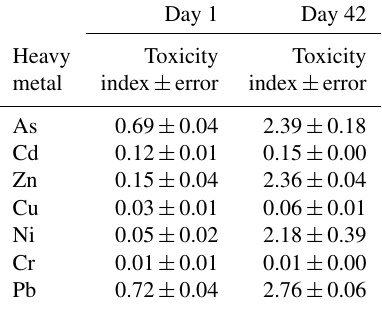
Table 1. Toxicity index values ± error of soil samples containing Cr, or Pb (individually), after 1 and 42d of